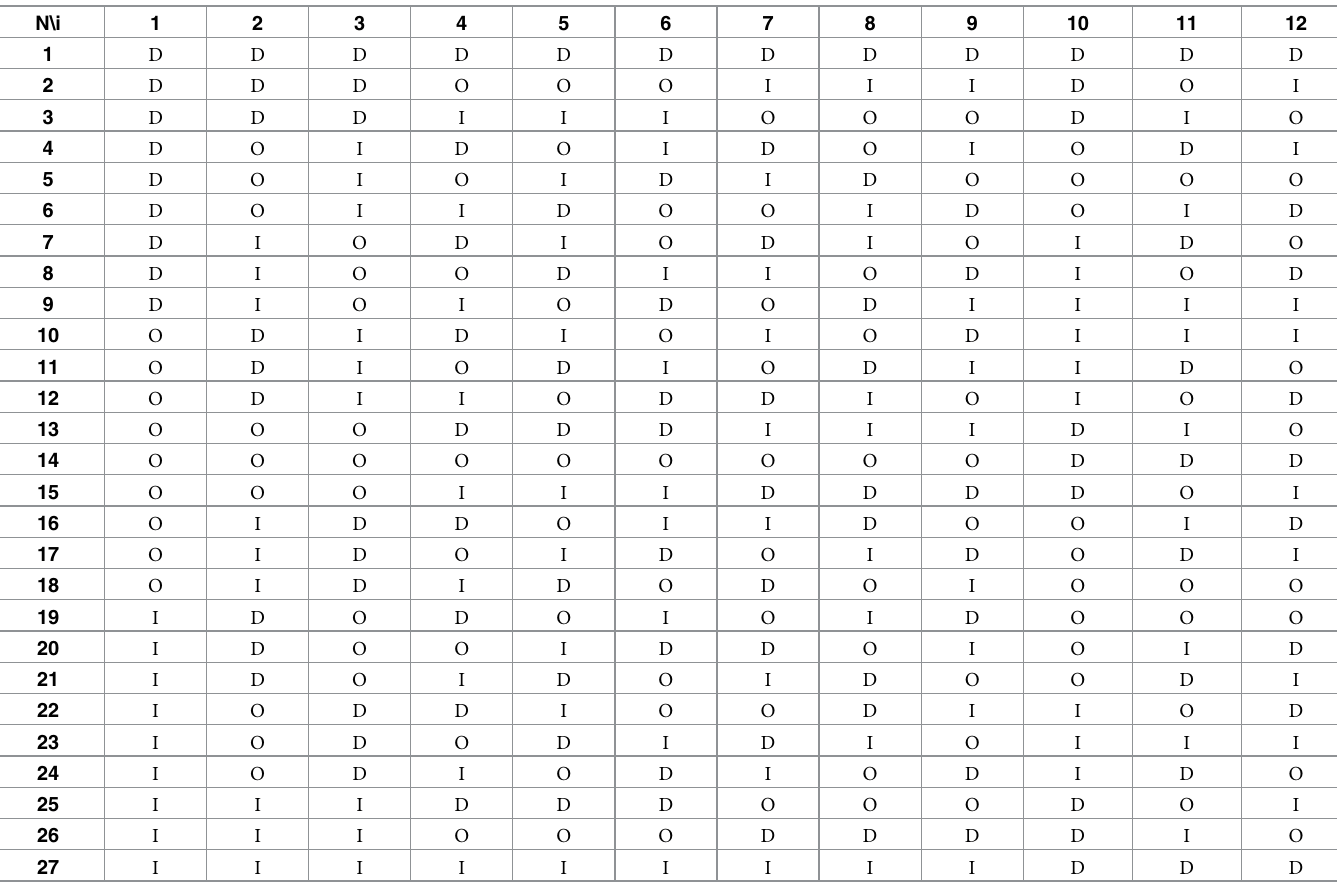
Table 3. Orthogonal array for weight